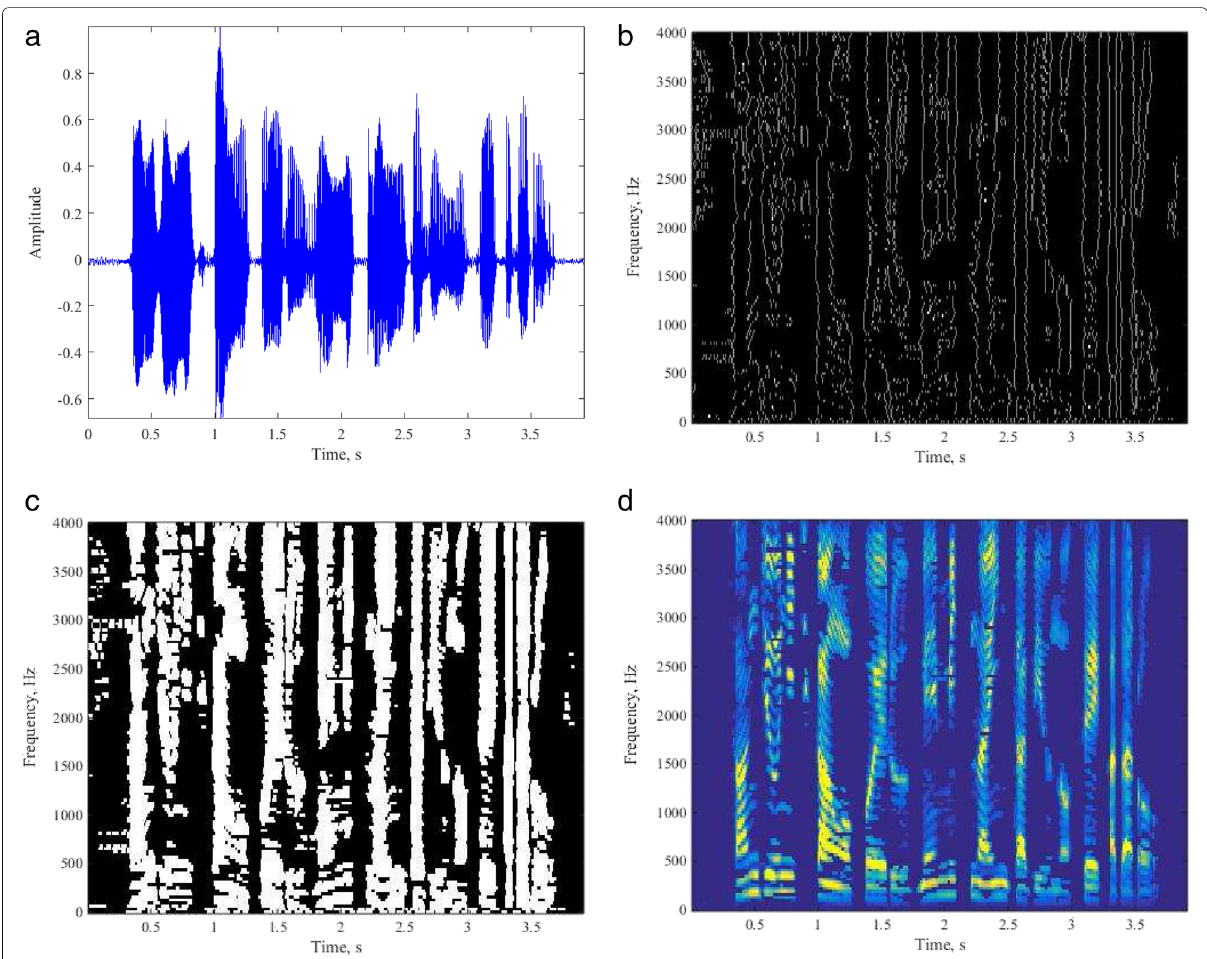
Fig. 5 Representation of a speech signal ( a ), its starting and ending point candidates using rules (i) and (ii) ( b ), masks ( c ), and speech period candidates as a result of multiplying masks by the spectra expressed in decimal form ( d